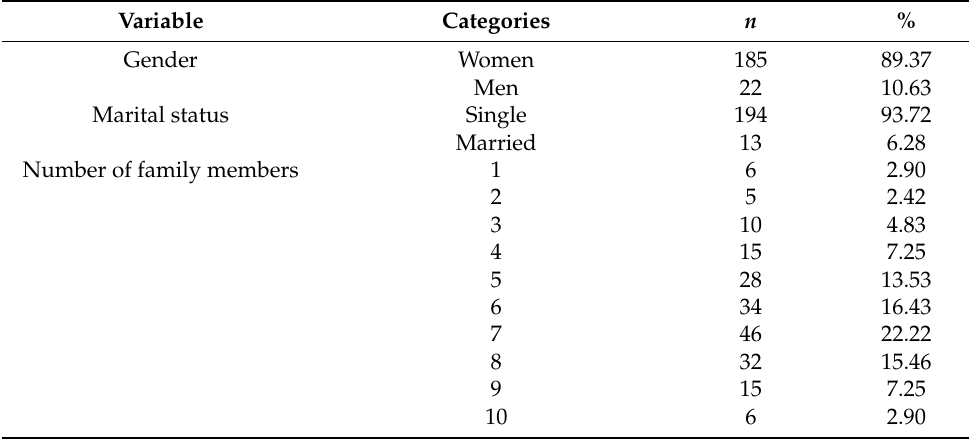
Table 1. Demographic characteristics of the